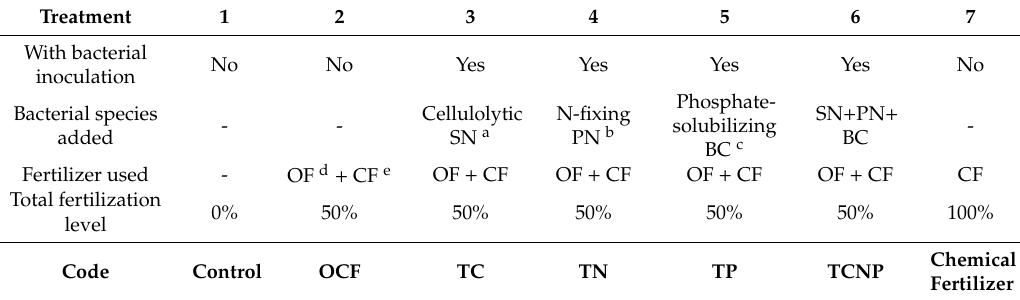
Table 1. Information on the treatments used in the greenhouse